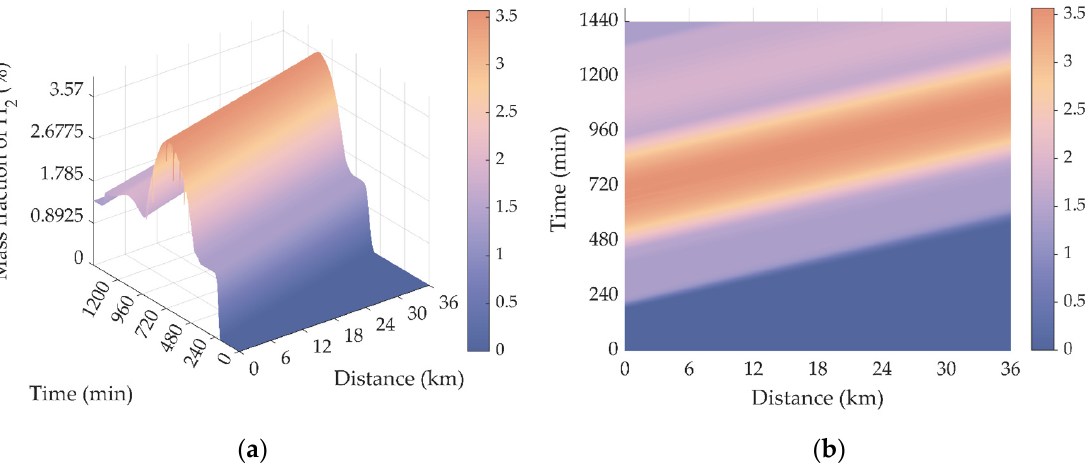
Figure 11. The distribution of hydrogen mass fraction in Pipe 4 in Scenario I: ( a ) Three-dimensional diagram; ( b ) top view.